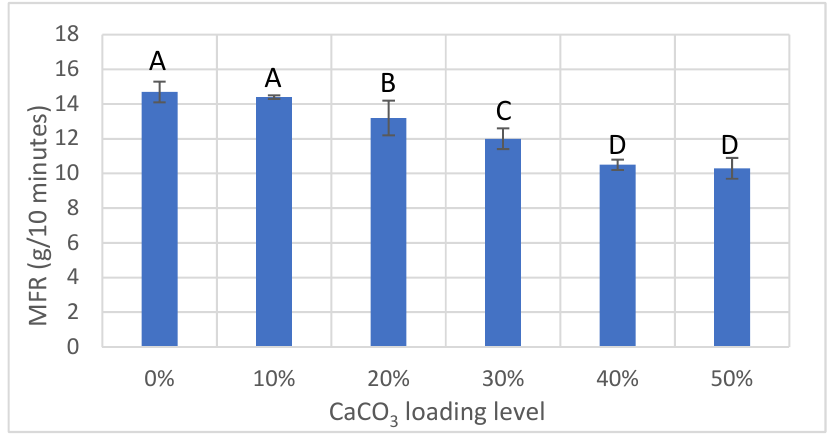
Figure 11. The MFR of HPP and CaCO 3 particles filled HPP. The letters A, B, C, and D represent the significant levels in statistical analysis. The values with different letters are significantly different.